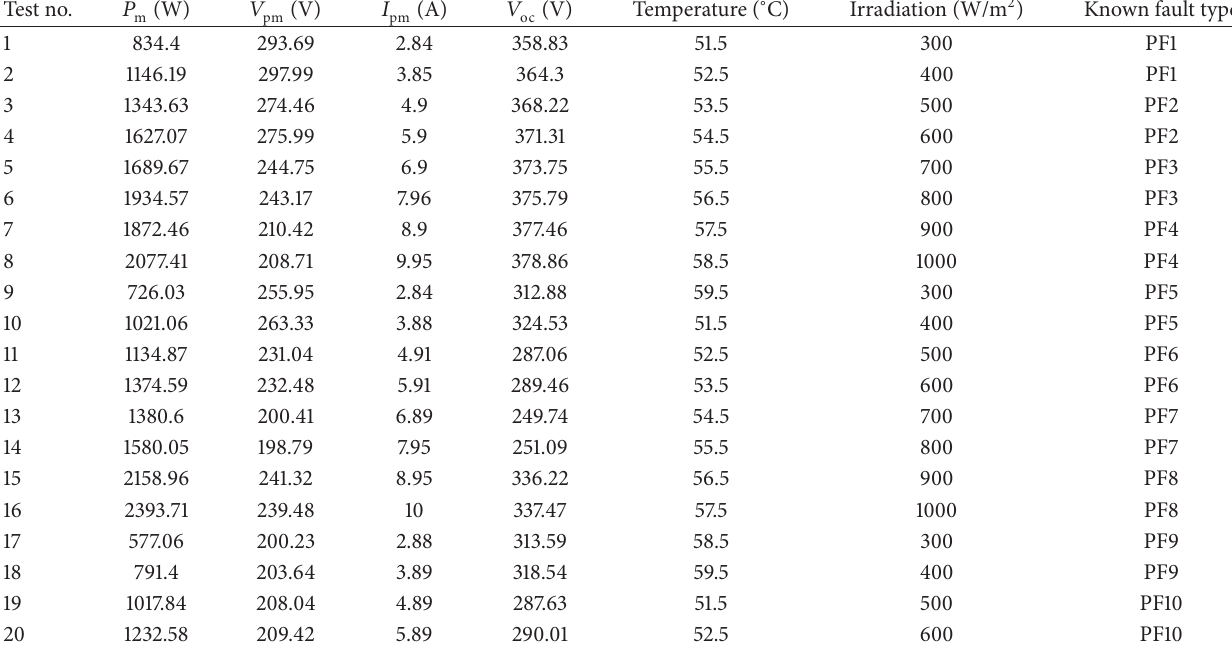
Table 6: Test data under 300–1000 W/m 2 irradiation and PV module surface temperatures between 51 and 60 ∘ C. Test no.